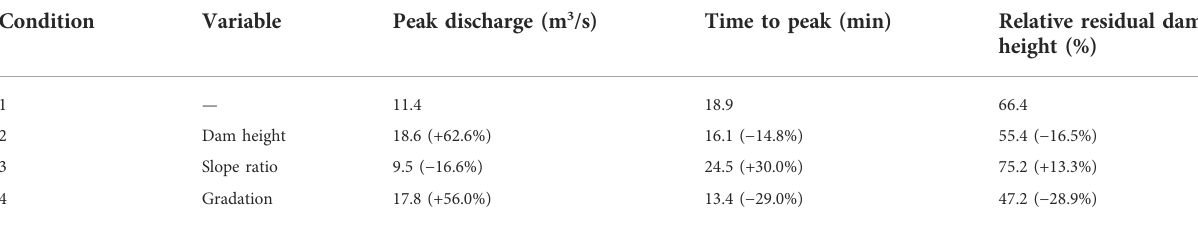
TABLE 4 Breach parameters of prototype dams for the four